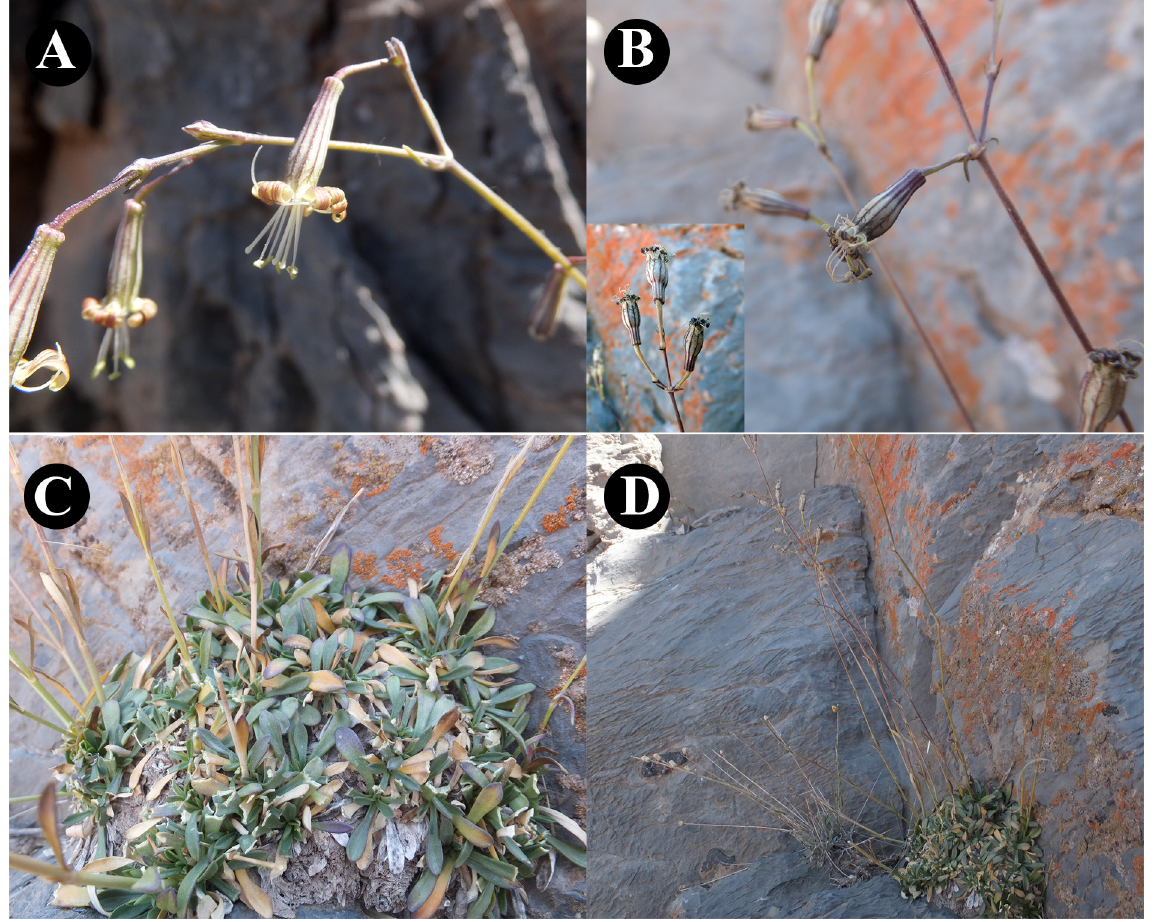
Fig. 8. Silene penduliflora F.Jafari, Keshavarzi & Doostm. sp. nov. (paratypes, M. Doostmohammadi & A. Ghorbanalizadeh 4054 ; MIR!. M. Doostmohammadi 4056 ; MIR!). A‒B . Inflorescence at flowering and fruiting times. C . Basal leaves and caudex. D . Habit and habitat. Photos by: M.